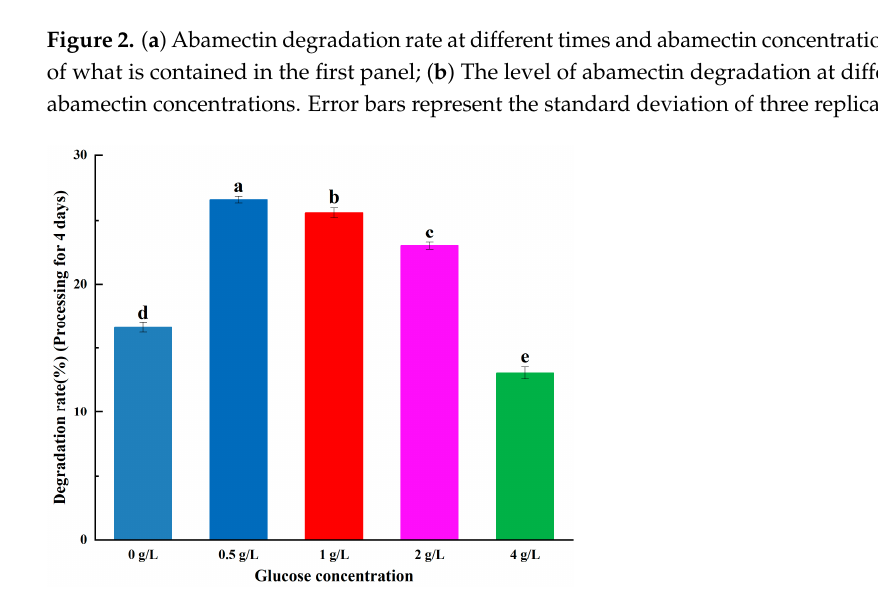
Figure 2. ( a ) Abamectin degradation rate at different times and abamectin concentrations. Descrip- tion of what is contained in the first panel; ( b ) The level of abamectin degradation at different times and abamectin concentrations. Error bars represent the standard deviation of three replicate exper- iments.